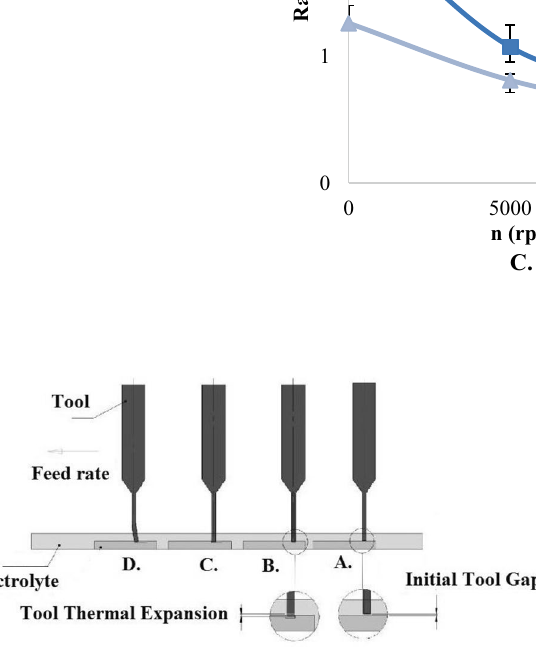
Fig. 10 Schematic view of tool contact with workpiece, a before start of machining process, b when process starts, c performing horizontal feeding, d feed rate more than material remove